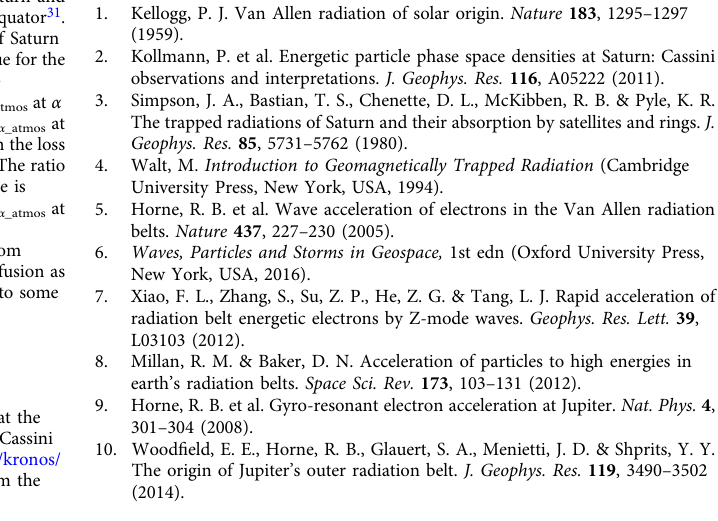
RBM. One further consideration when calculating the diffusion coef fi cients for the Z-mode waves is the presence of a reverse resonance cone which exists where the wave frequency is lower than the upper hybrid frequency but higher than both the electron gyro frequency and plasma frequency. We have included scattering from particles in the neutral torus created by Enceladus by calculating a value of pitch angle scattering for the presence of water ions. We use a model of water ions from Enceladus 29 to calculate D αα _ torus 30 . We have assumed that the neutral torus is azimuthally symmetric around Saturn and consists of H 2 O, OH, and O with a de fi ned scale height away from the equator 31 . We have included the pitch angle scattering due to the atmosphere of Saturn using the same method 30 to calculate D αα _ atmos . This gives a very high value for the total D αα at pitch angles up to the loss cone angle. To avoid cubic spline interpolation overshoot issues near the loss cone we use the value of D αα _ atmos at α = 0° and then we use a quadratic curve to join this up to the value of D αα _ atmos at the pitch angle grid point closest to the loss cone. The loss timescale within the loss cone is based on the time taken for the electron energy to decay 32 by 1/ e . The ratio of D αα _ atmos to the loss time is calculated at α = 0° and then the loss time is calculated at other points inside the loss cone using this ratio and the D αα _ atmos at Cassini electron data 2 . We regard this as an upper limit for the radial diffusion as the value is likely to be contaminated by wave – particle interactions and to some extent the CRAND process.